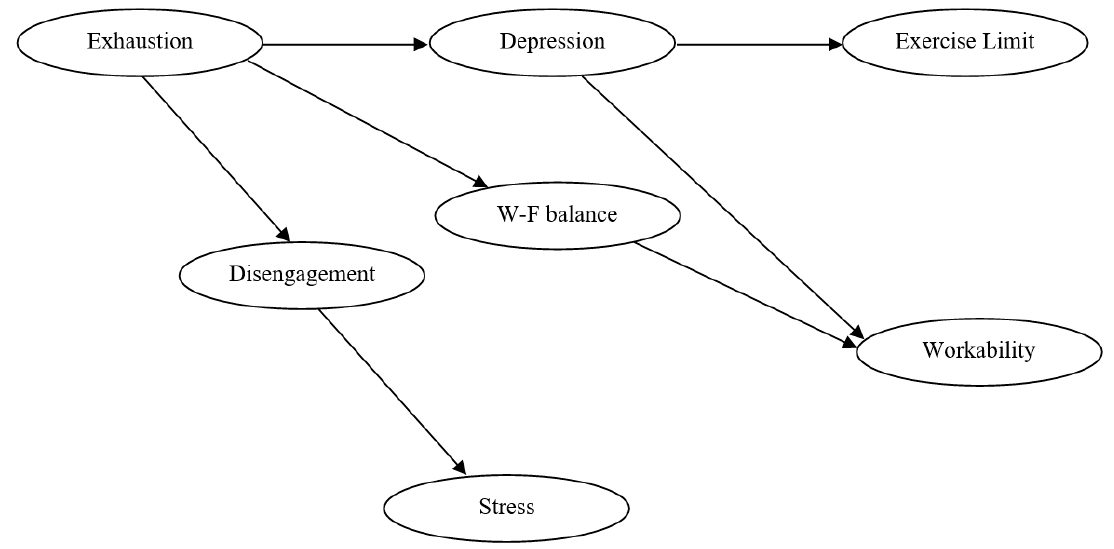
Figure 1. Final Bayesian Network model: the most probable scenario of the potential negative outcomes of correctional work. notes: W-F balance = Work-Family balance (work to family and family to work conflict); Exercise Limit = Limitations to regular physical leisure exercise.